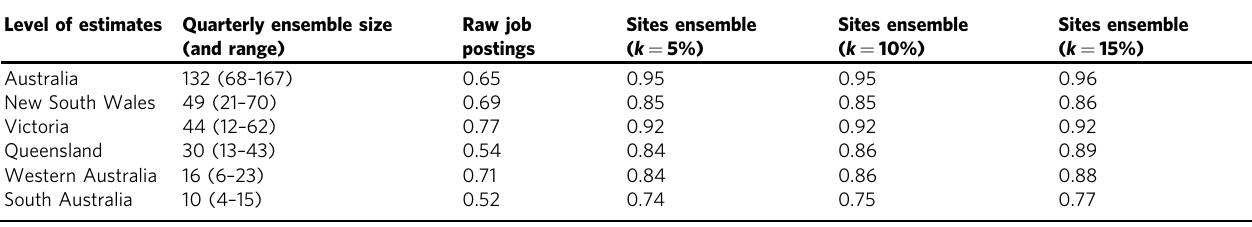
Table 1 The methods ’ correlations with the Job Vacancies Survey estimates across the 18 quarters from May 2018 to August 2022.